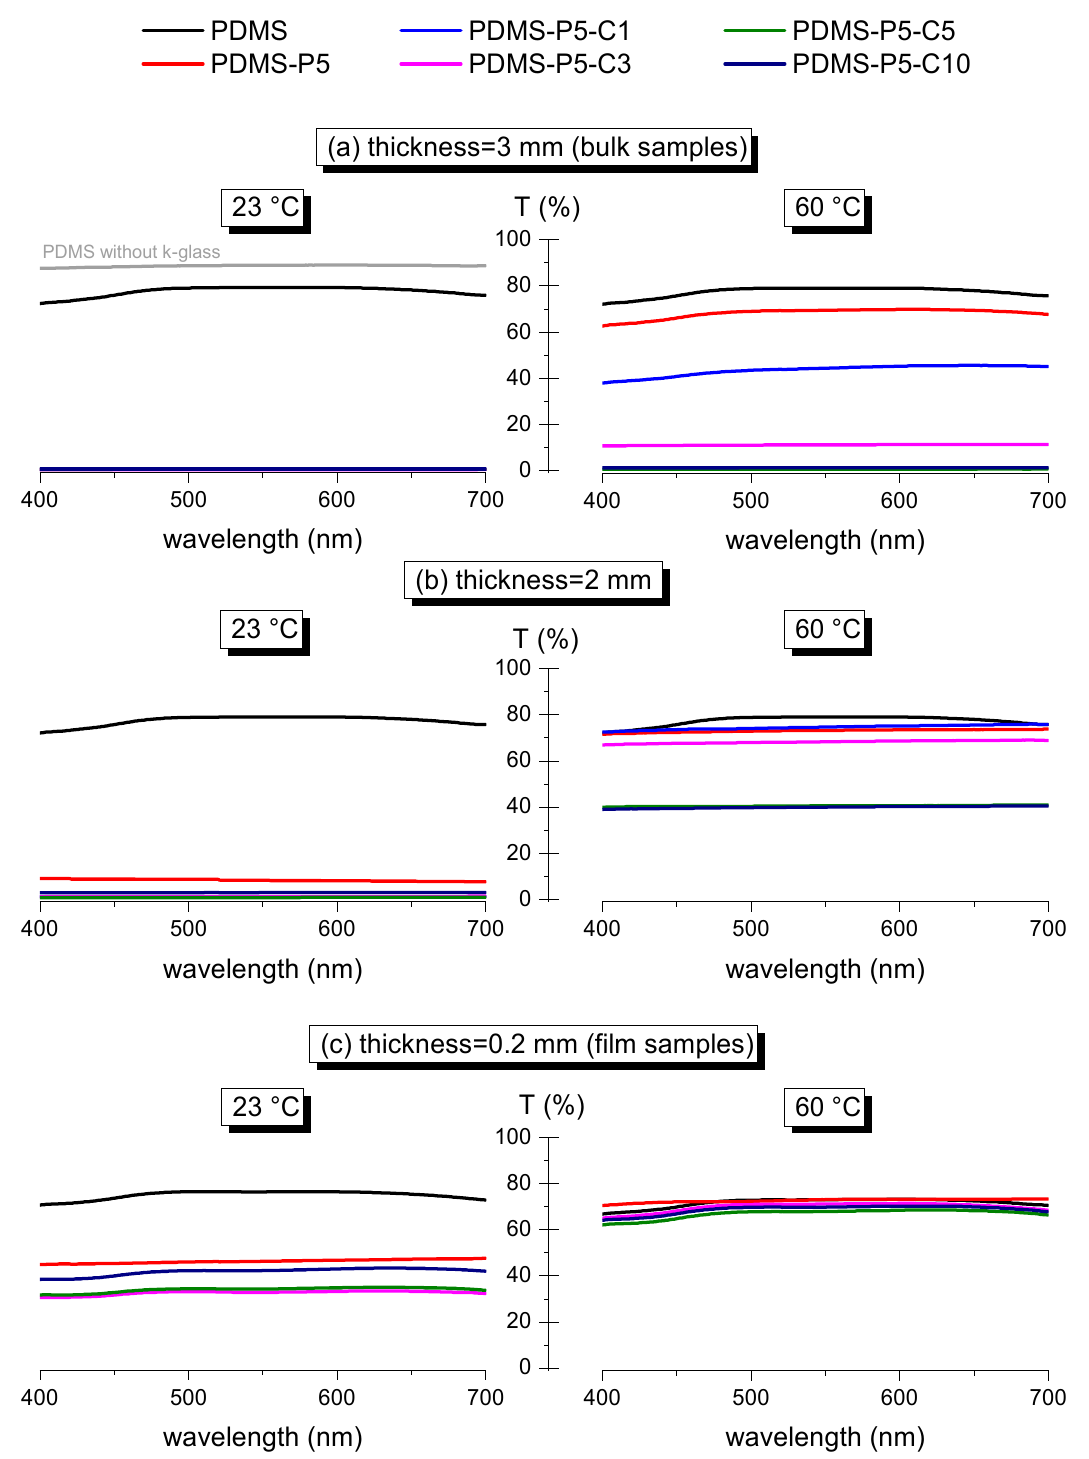
Figure 9. Transmittance as a function of the wavelength at 23 °C and 60 °C for samples of variable thickness. All tests were performed with a K-glass substrate (see Section 2.3).